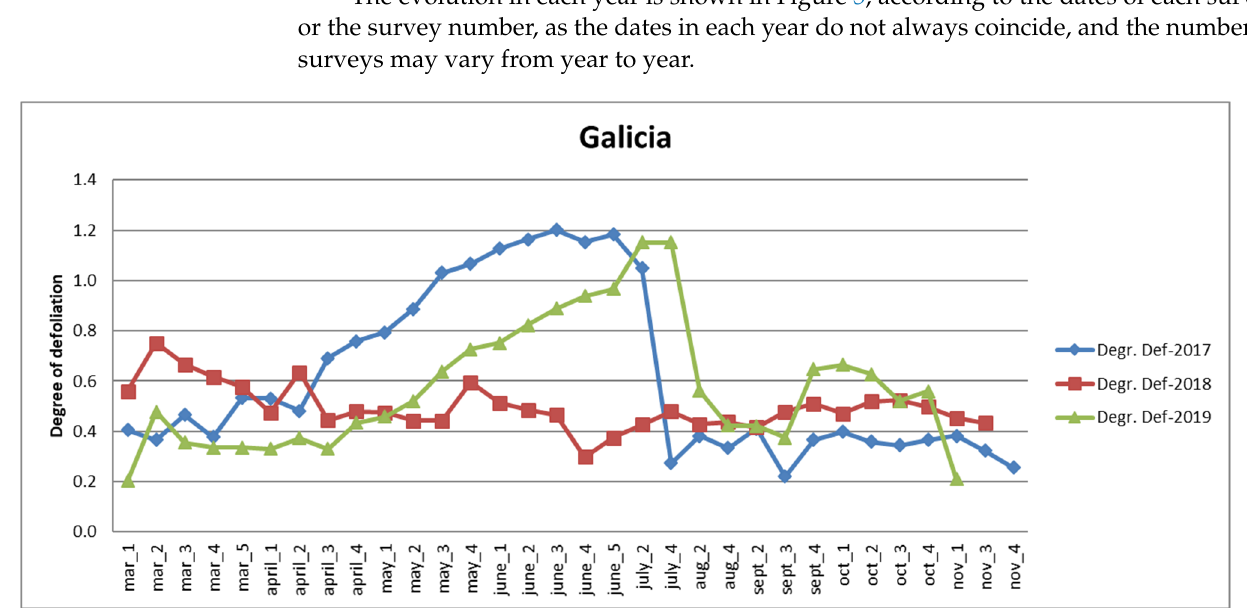
Figure 6. Number of plots sampled in Galicia in 2020 by week and degree of defoliation. The total number of adults was also evaluated for each year according to the survey (Figure 7). In this case, the dates are shown by the number of the week in the month, as they are not the same each year.